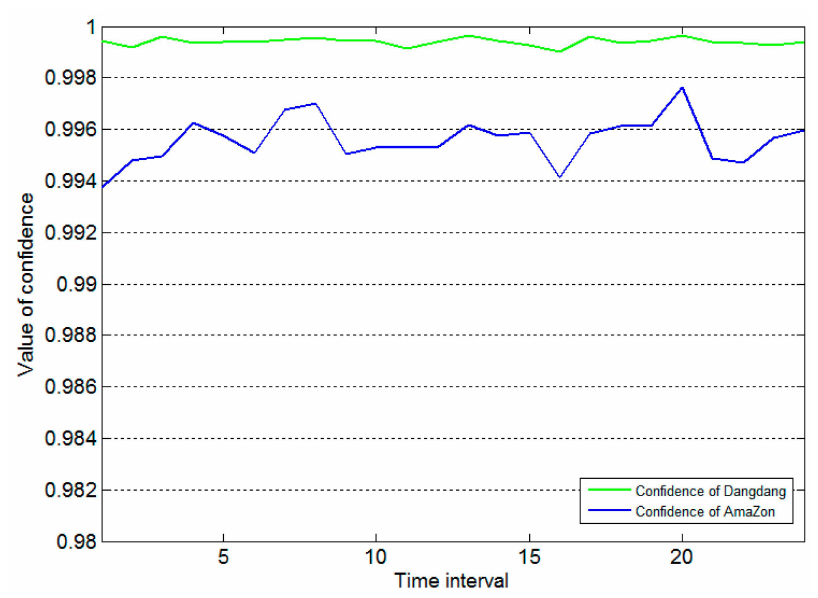
Figure 8. Variation values of confidence of multi-dimensional direct trust over 24